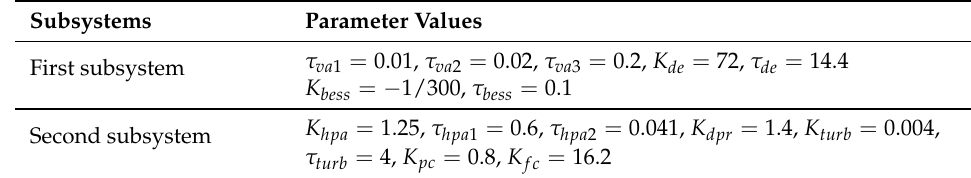
Figure 5. Real-time simulation using OP5700. Table 1. Model parameters